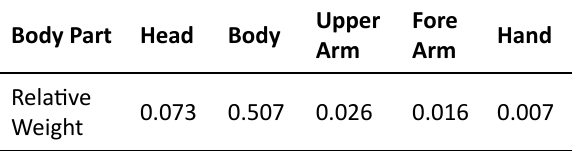
Table 1. Relative weight values of body parts